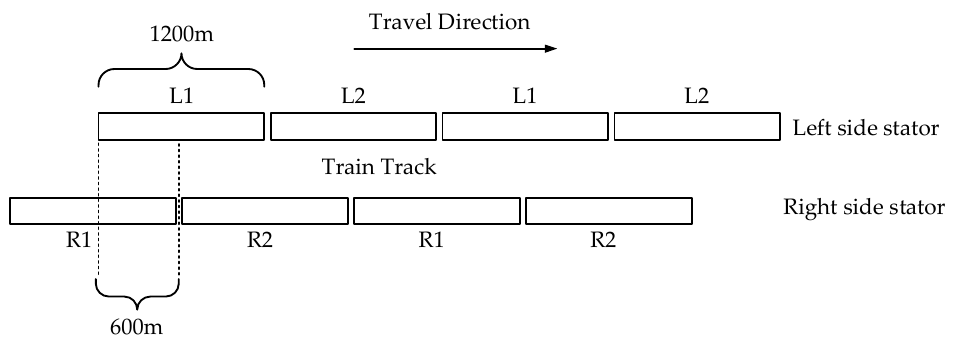
Figure 4. Modeling of four stators.